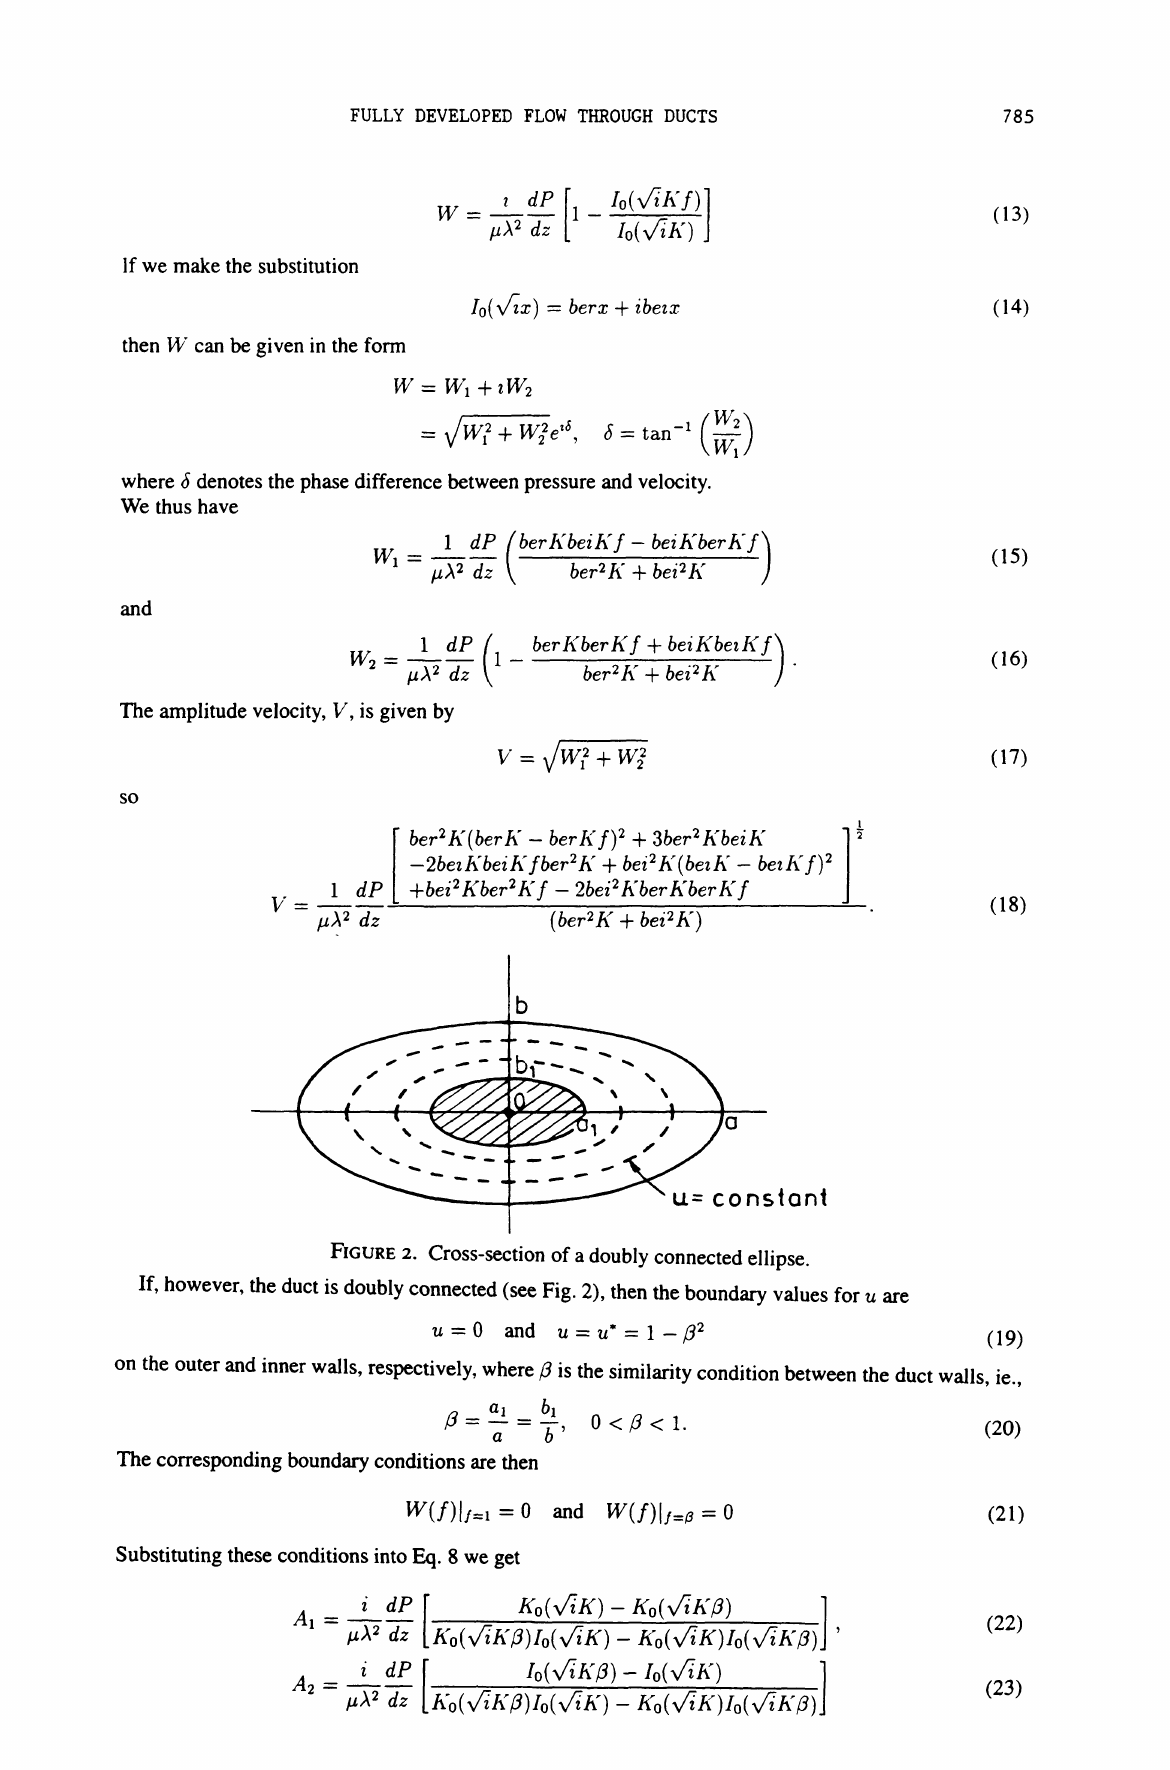
FIGURE 2. Cross-section of a doubly